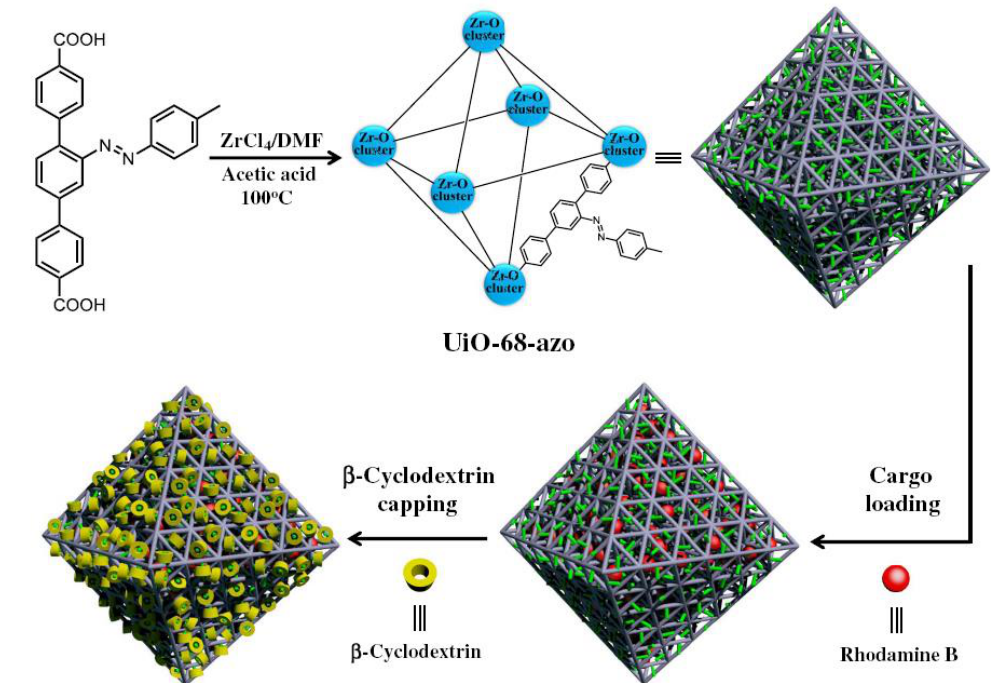
Figure 3. Schematic illustration of UiO-68-azo, as well as rhodamine B-loaded, β-CD-capped UiO-68-azo. The trans -azobenzene is colored in green. Reproduced from Reference [17] with permission from the American Association for the Advancement of Science, copyright 2016.